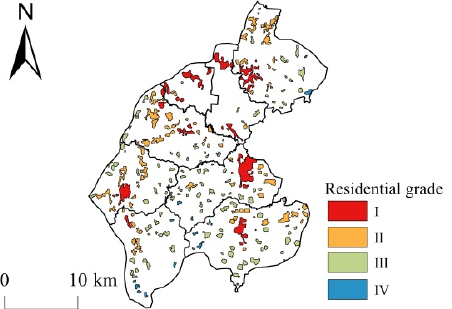
Figure 8. The spatial pattern of rural settlements at different levels in Pingyin